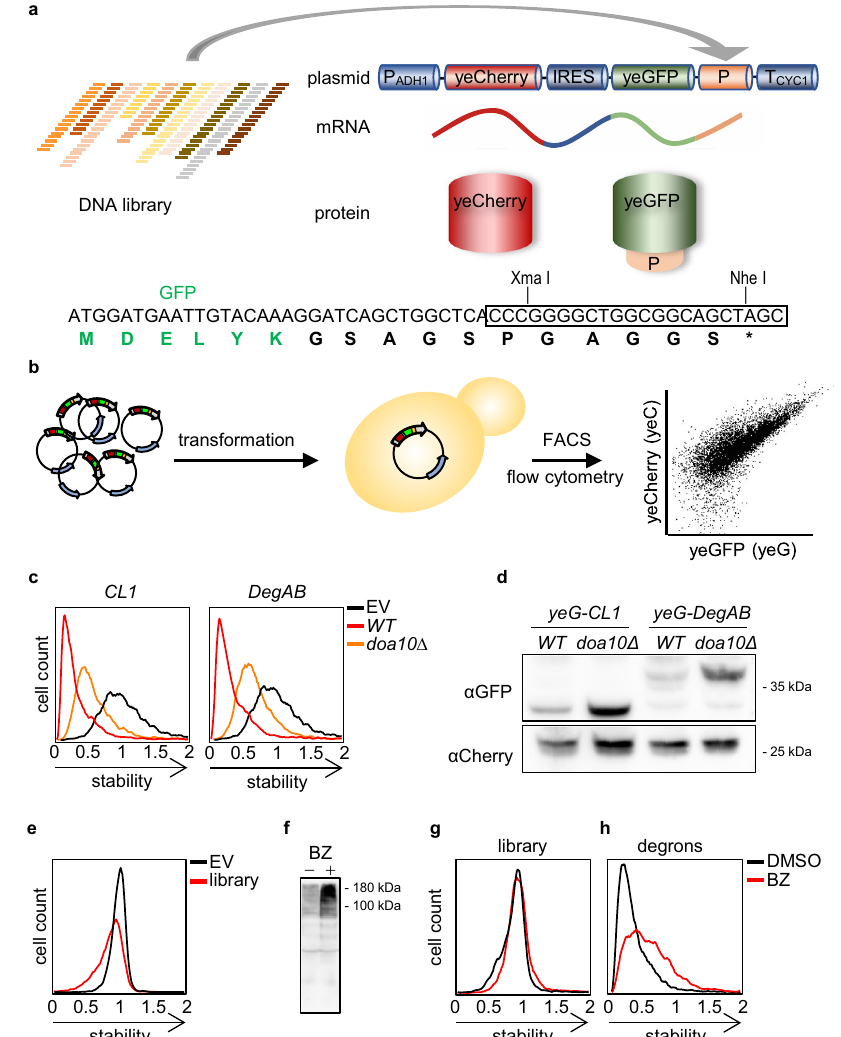
Fig. 1 | Principles and validation of the yGPS-peptidome method. a Schematic representation of yGPS-peptide library (yGPS-P lib ) where a DNA library comprised of 51-mer tiled DNA fragments from 326 proteins, represented by different colors, are cloned in-frame downstream to GFP in the yGPS-P vector. The single mRNA product consists of yeCherry-IRES-yeGFP-peptide. DNA and protein sequences illustrate the cloning site that pursues GFP and the pentameric linker. b Flowchart of the degron screen. yGPS-P lib is transformed into yeast, followed by fl ow cyto- metryor FACS. c Flow cytometryhistograms of CL1 and DegAB degrons appended to yGPS-P, in wild type and doa10 Δ cells. Fluorescence emissions of 10,000 cells were determined for each condition. Stability scale: Median value of the yeG/yeC ratio in empty vector (EV) control was set as one. All other histograms were